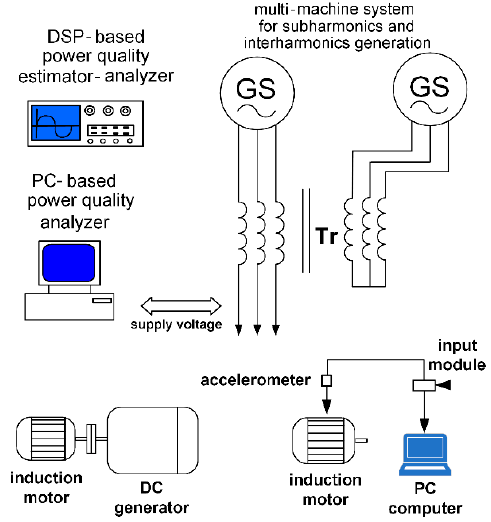
Figure 1. Simplified diagram of the measurement stand.